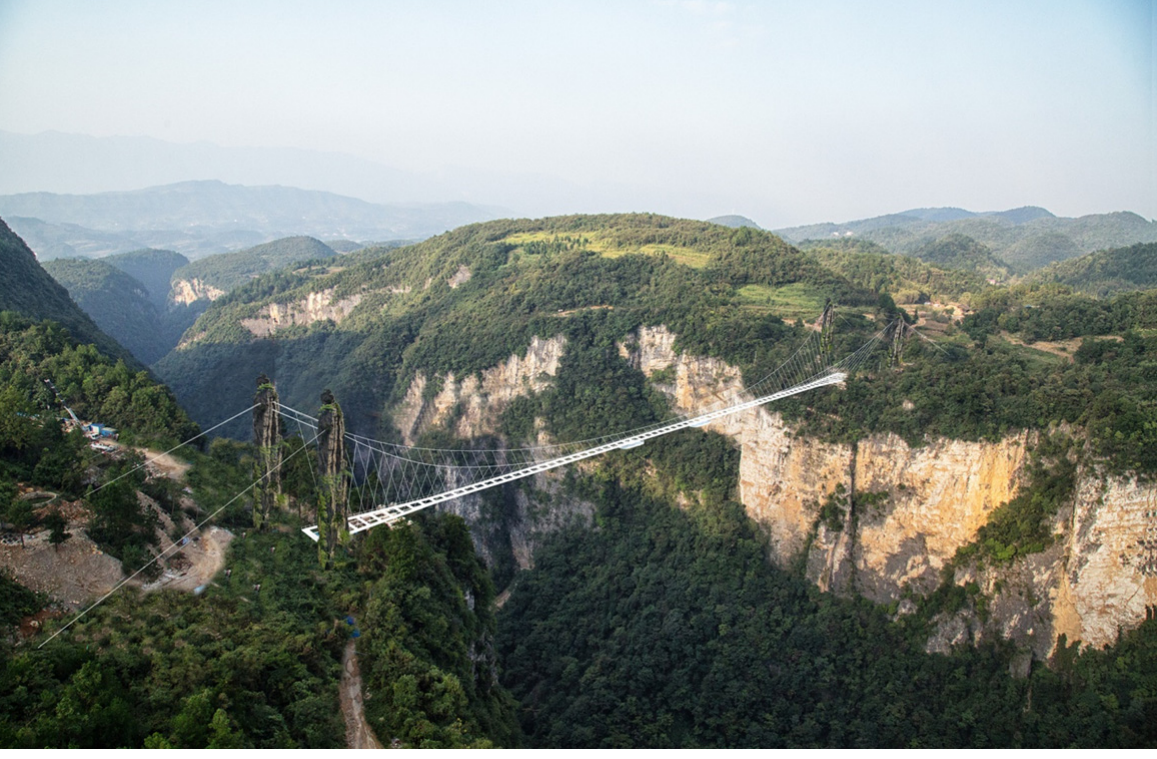
Fig. 1 Zhangjiajie Bridge, aerial view